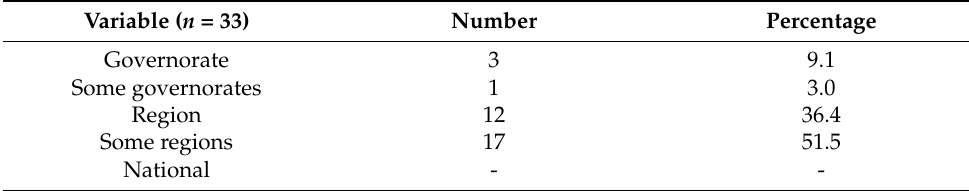
Table 7. The geographical coverage of the partnerships examined.